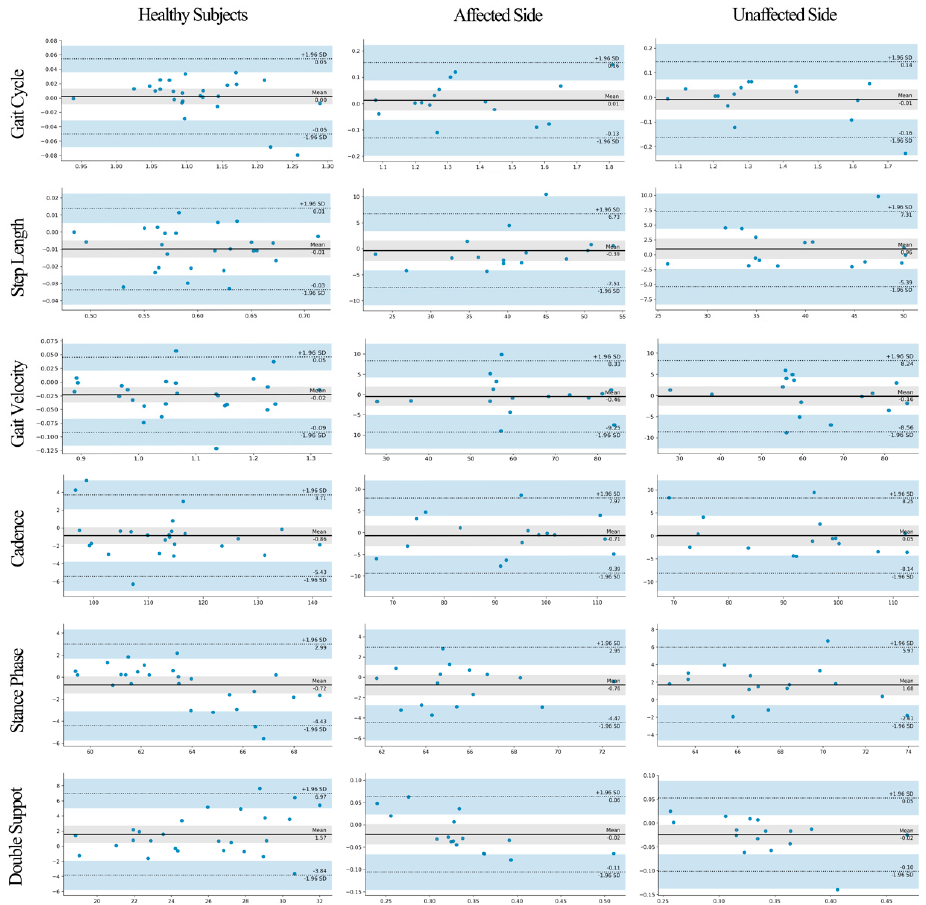
Figure 3. The Bland − Altman plots for the differences between the spatiotemporal parameters measured by Odonate and Vicon systems. The absolute differences between each data pair are plotted against their means. The two horizontal lines represent the 95% limits of agreement (range of error) and are calculated as 1.96 times the standard deviation of the mean difference between the two systems. The figure illustrates that the differences between the two systems lie evenly within the limits of agreement.